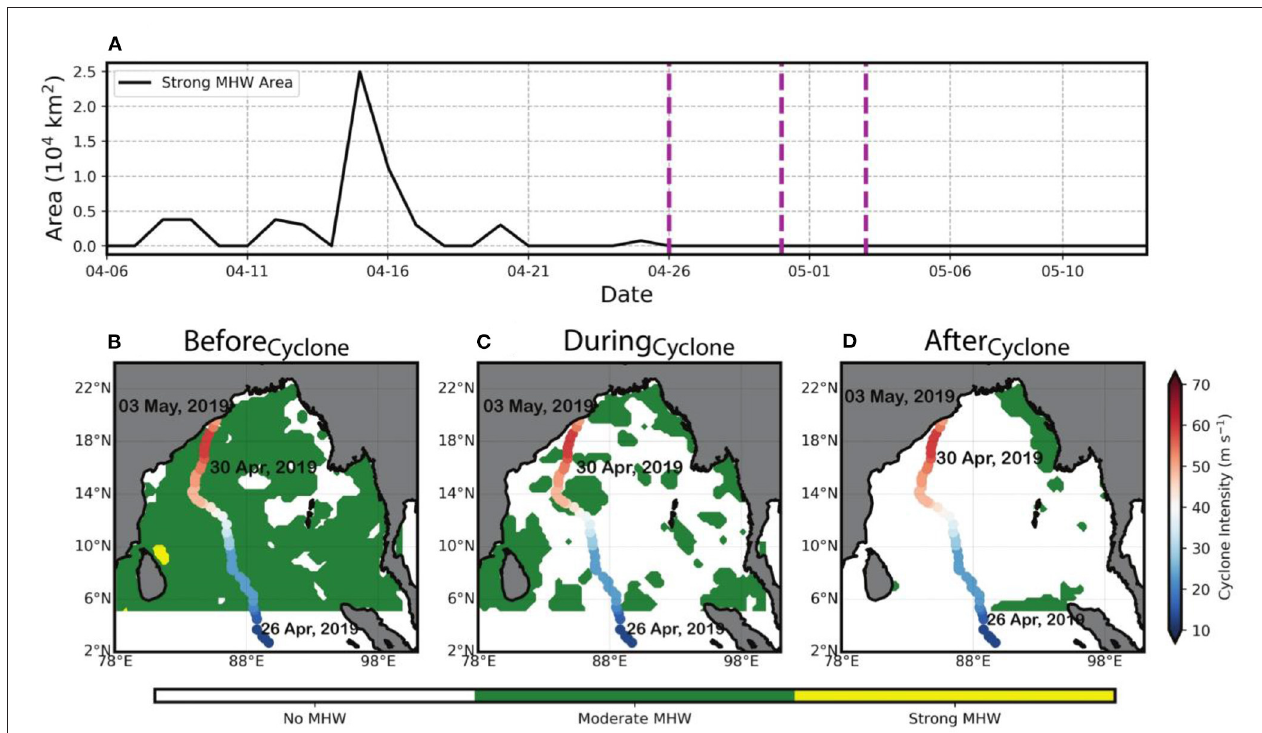
FIGURE 9 | (A) Ocean surface area of the Bay of Bengal covered by strong marine heatwave conditions with vertical magenta lines representing cyclogenesis (left, 26-Apr-2019), cyclone intensification (middle, 30-Apr-2019) and landfall (right, 3-May-2019) for the tropical cyclone Fani, (B–D) categories of marine heatwave over the Bay of Bengal before the tropical cyclone Fani (averaged over 22–25 Apr 2019), during the cyclone (averaged over 26 Apr-3 May 2019) and after the cyclone (averaged over 4–8 May 2019) overlaid by the track of the cyclone which is shaded by its mean daily intensity (m s − 1 ) with the date of genesis (26-Apr-2019), date of extremely severe cyclonic storm (30-Apr-2019) and landfall (3-May-2019) as extremely